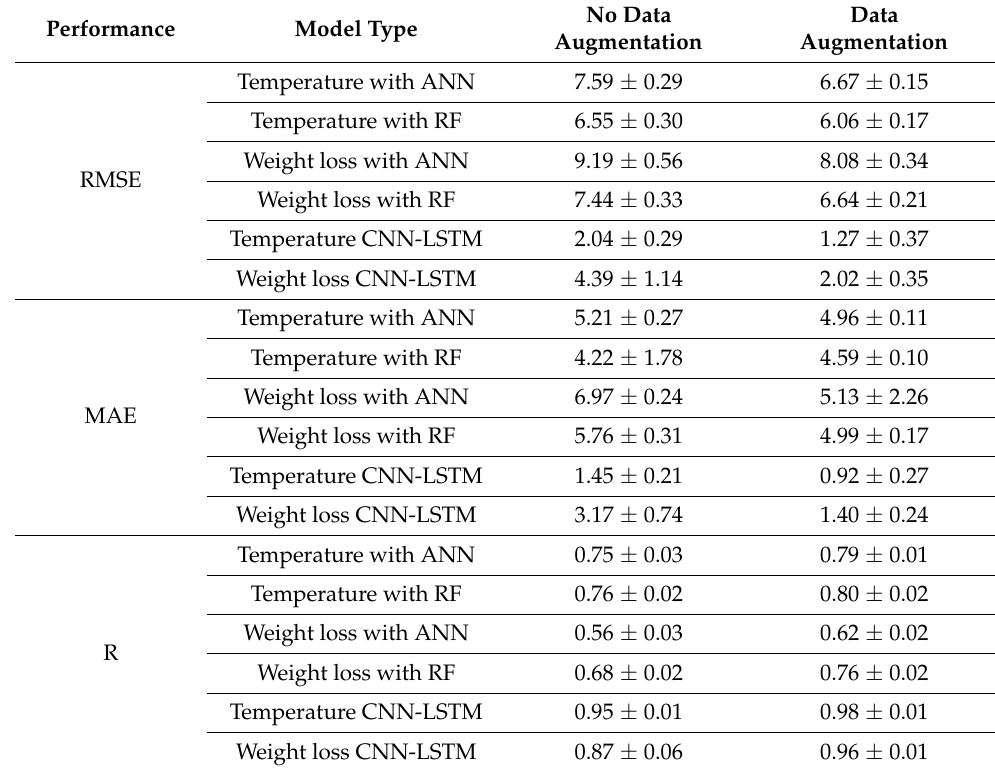
Figure 12. The result of a transfer-learning-based CNN-LSTM regressor model for predicting HU using temperature and weight loss data. The source CNN-LSTM regressor is only used for temperature data and the target CNN-LSTM regressor used only weight loss data: ( A ) the results without data augmentation; ( B ) represents the results with data augmentation. Table 2. The HU prediction result of transfer-learning based stacked convolutional neural network with long short-term memory regressor using temperature and weight loss data.